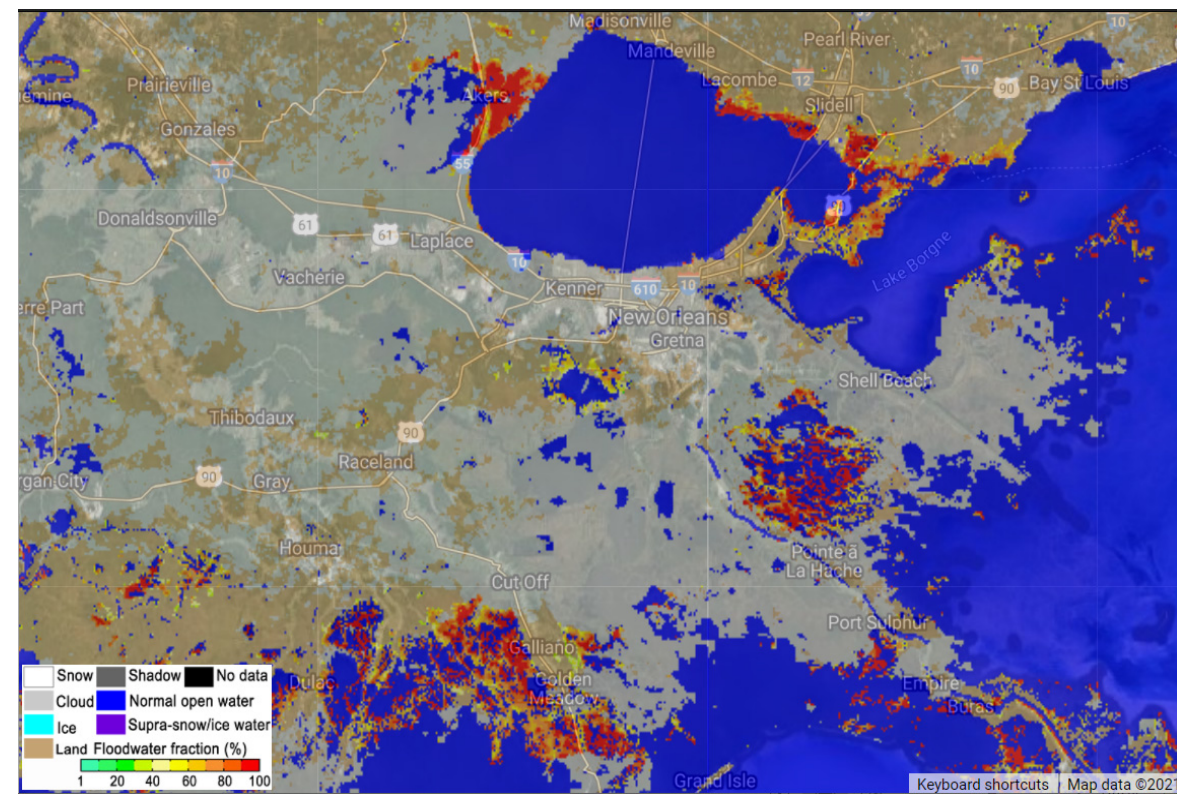
Figure 4. VIIRS map of flooding caused by Hurricane Ida in the Louisiana region on 31 August 2021.